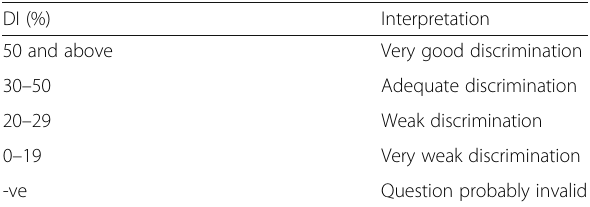
Table 2 Interpretation of DI (discrimination index values) of each question (adapted from Moodle Statistics,